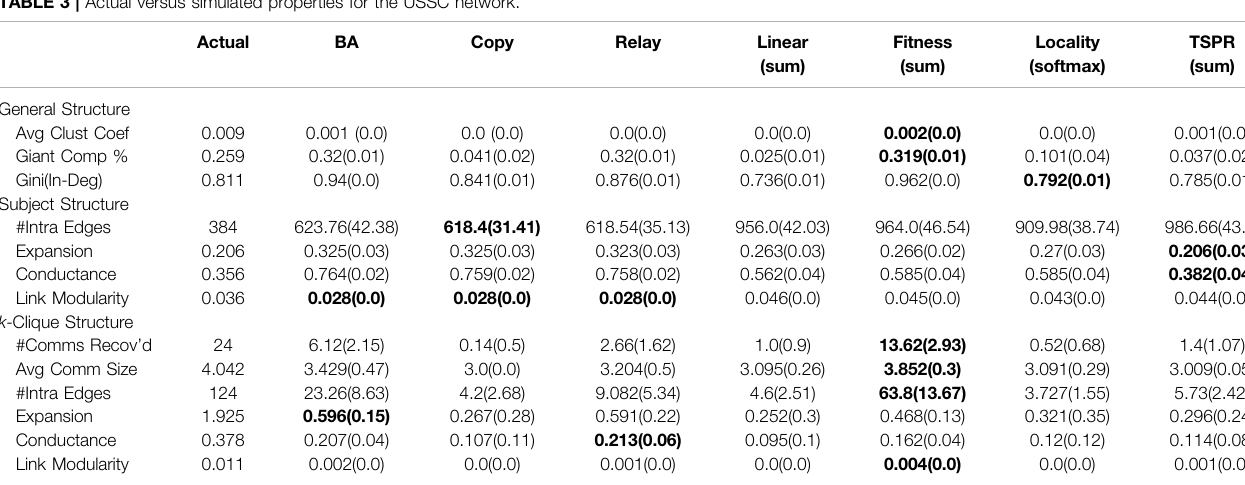
TABLE 3 | Actual versus simulated properties for the USSC network. Actual BA Copy Relay Linear